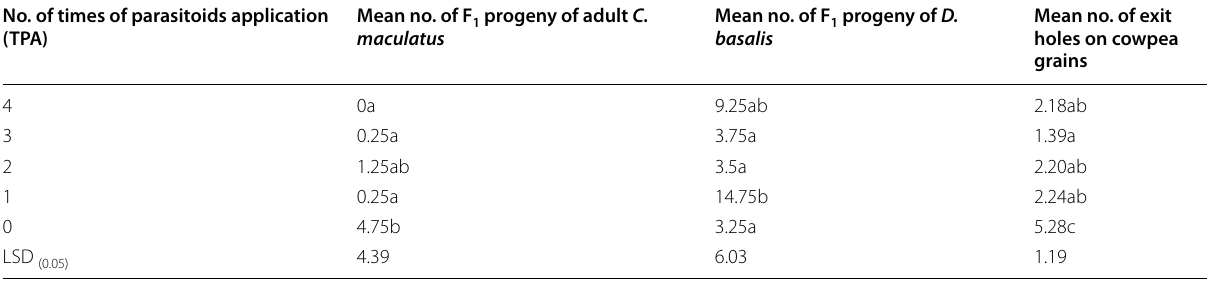
Means were separated using Fisher’s Least Significant Difference at 5% level of